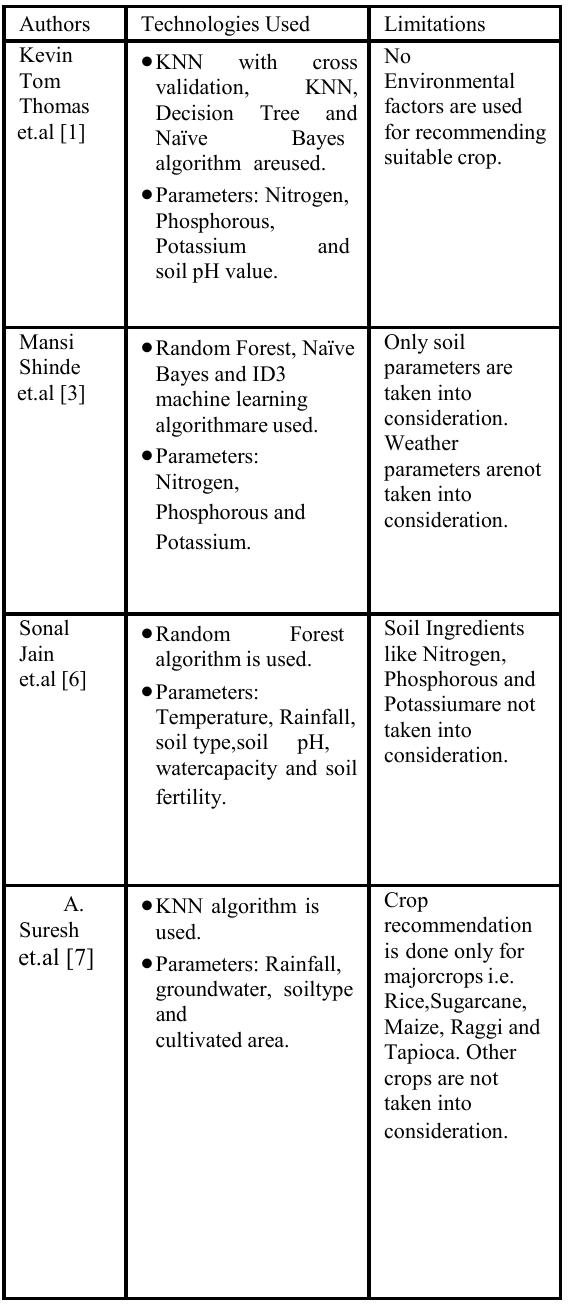
Table 2.1. Limitations of reviewed